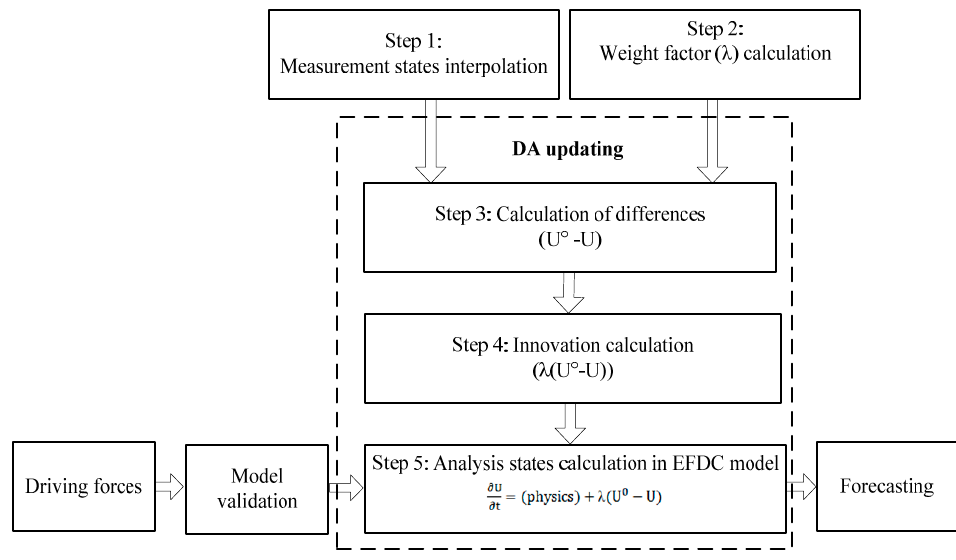
Figure 4. Flow chart of implementing a nudging algorithm in EFDC model